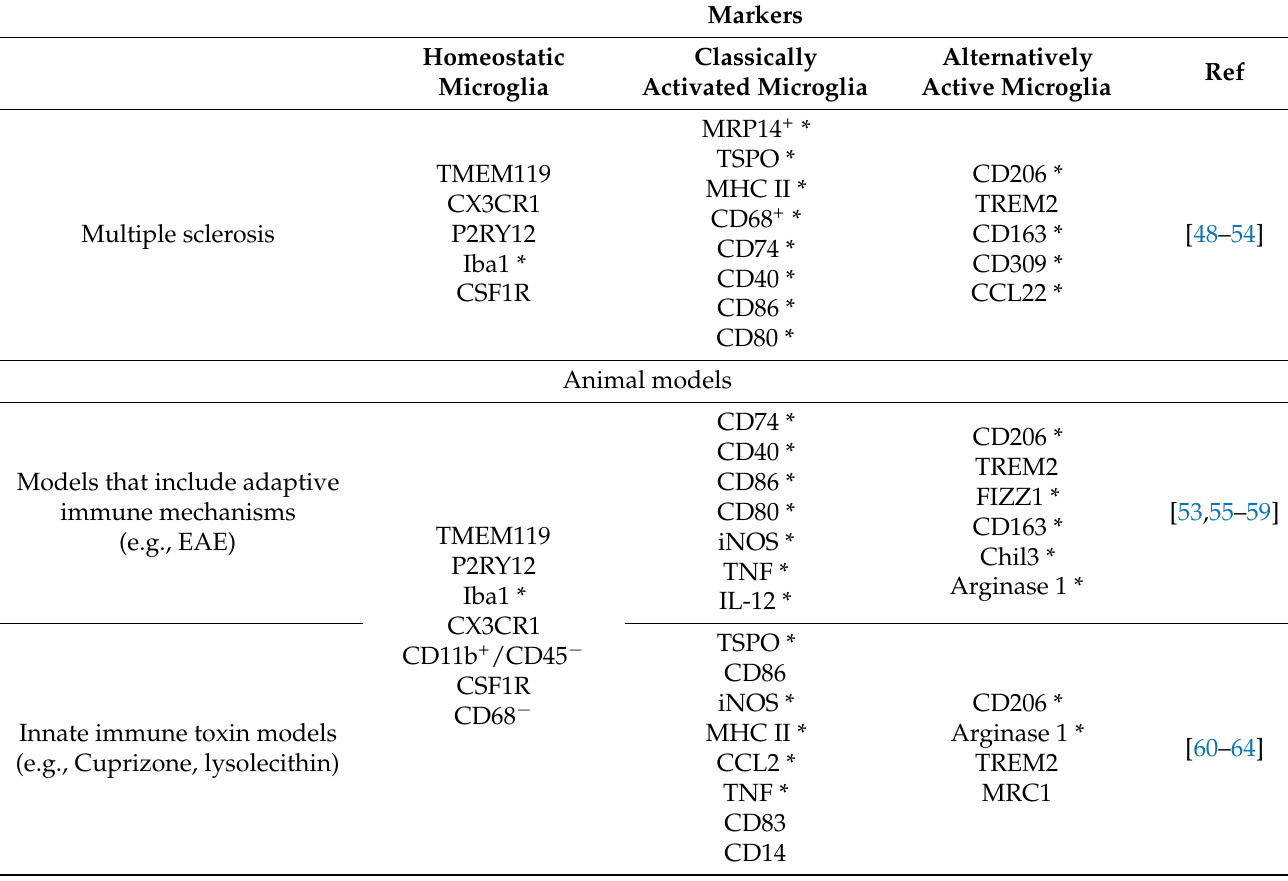
Table 1. Commonly used markers for different states of microglia in multiple sclerosis and specific animal